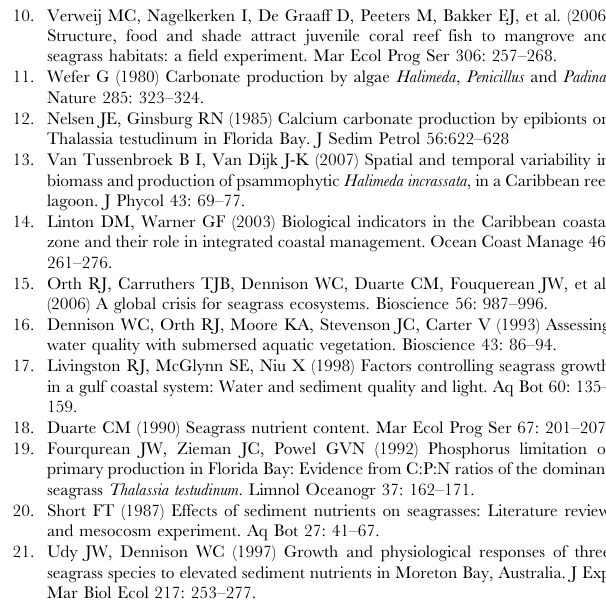
Table S6 Regression lines of trends. Results for the linear regressions of selected parameters vs year to indicate possible trends Regressions were computed for those stations and parameters when the sampling covered at least 5 y with at least six sampling events and at least 50% of the samples had values .